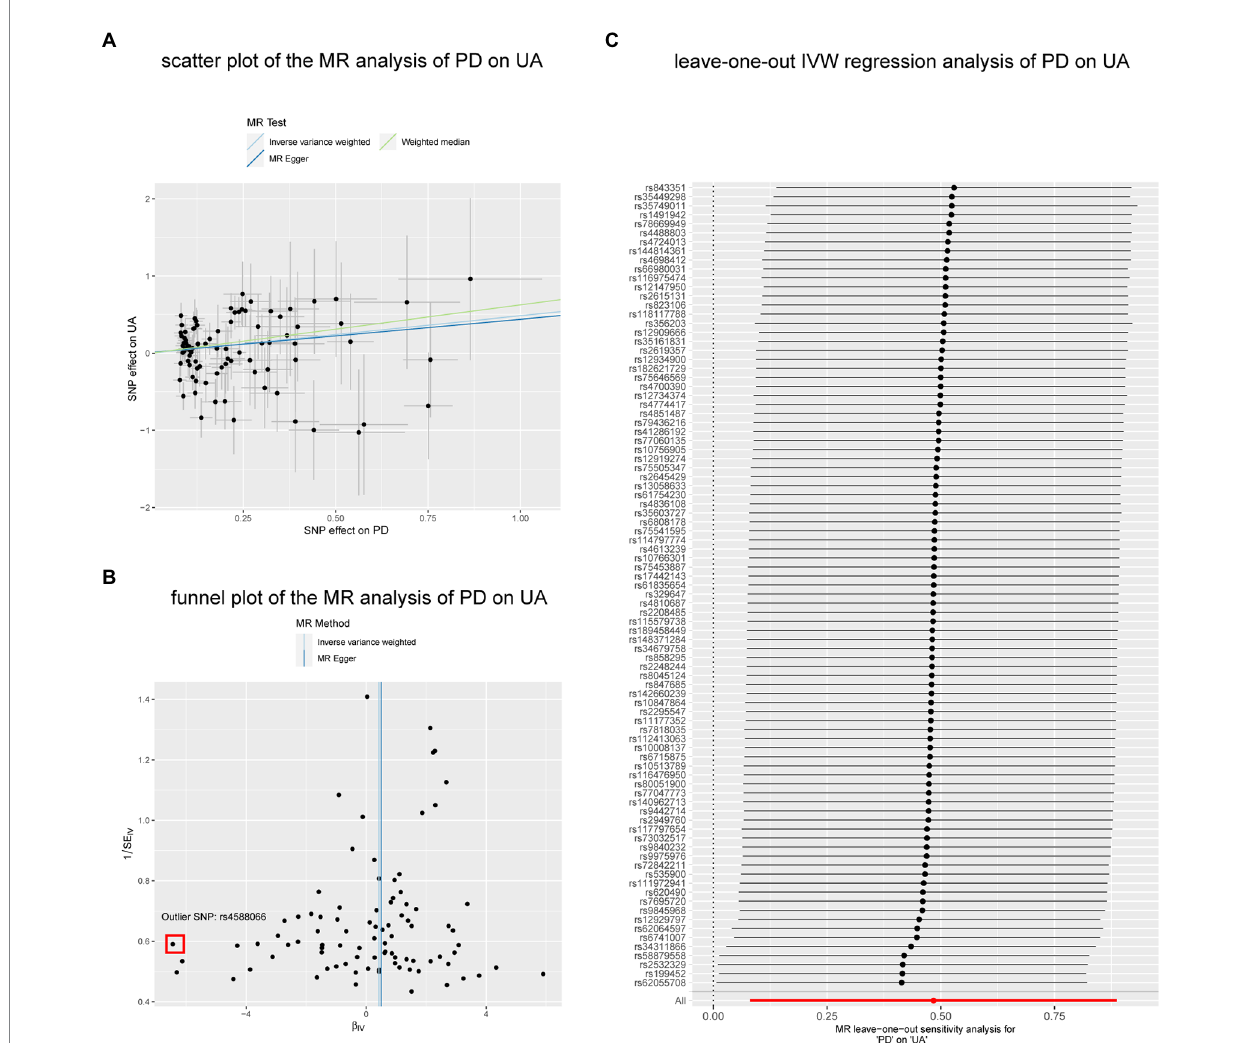
FIGURE 5 The nominal associations between PD and UA. (A) Scatter plot of the MR analysis of PD on UA. (B) Funnel plot of the MR analysis of PD on UA. (C) Leave-on -out IVW regression analysis of PD on UA. Abbreviations: PD, Parkinson’ s disease; UA, uric acid; IVW, inverse variance weighted method; SNP, single nucleotide